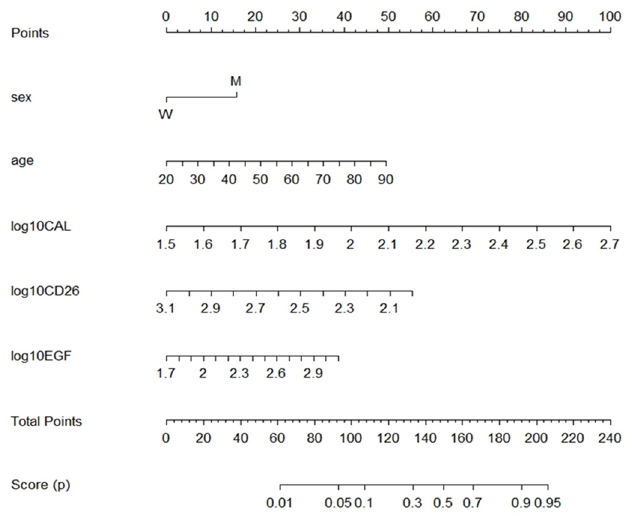
Fig 2. Nomogram for prediction of the classification score p for lung cancer. Multivariable logistic regression model-based nomogram to define lung cancer score p based on Calprotectin, sCD26 and EGF concentration (log transformed), gender and